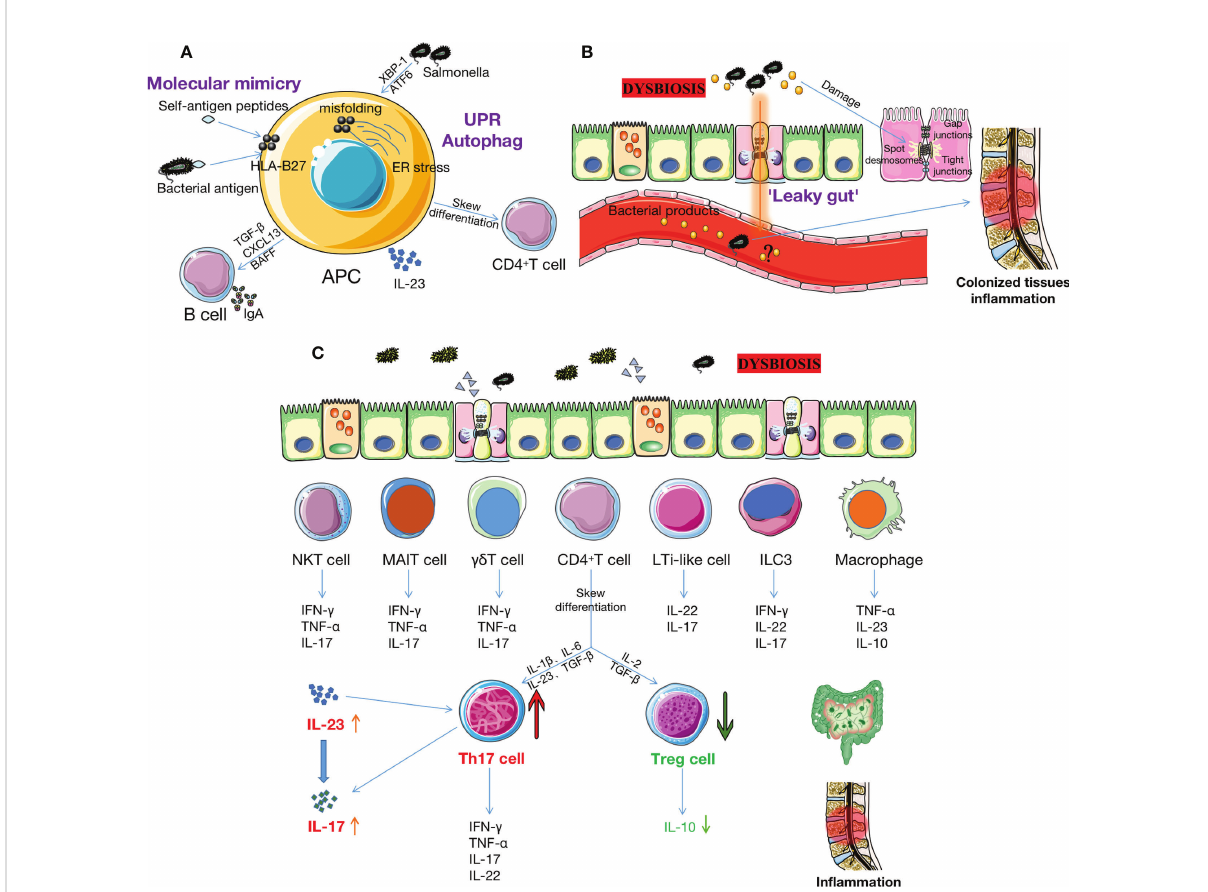
FIGURE 2 The intestinal microbiome and its metabolites may contribute to AS pathogenesis. (A) The interaction of gut microbiota and HLA-B27 may increase the risk of AS through two mechanisms. Firstly, HLA-B27 provides speci fi c peptides, such as certain bacterial antigenic components (e.g.polypeptide structures of Klebsiella and Shigella), to APCs (e.g., CD8+ T or DC cells), resulting in cross-react on molecularly similar self- peptides. Secondly, misfolding of HLA-B27 within ER leads to ER stress, which triggers the UPR or autophagy, activating IL-23/IL-17 axis in the bowel and joints and simultaneously activating B cells to secrete IgA. However, the role of UPR in HLA-B27-driven in fl ammation has not been demonstrated in humans. (B) Dysbiosis leads to increased permeability between IECs, associated with reductions in cathelicidins and mucins, disruption of TJ proteins, impairment of GVBs, etc. Bacteria and bacterial products subsequently enter the bloodstream, inducing in fl ammation of the colonized tissue. However, it is uncertain whether there is bacterial translocation in AS patients. (C) Many immune cells (e.g., Th17, Treg, ILC3, MAIT, gd T, NKT, LTi-like cells, DCs, macrophage et al.) reside in the intestinal mucosa. Dysbiosis triggers these cells to increase pro- in fl ammatory cytokines (such as IL-17, IL-23, TNF- a , IFN- g , IL-7, IL-22, et al.) and decrease anti-in fl ammatory cytokines (such as IL-10). This activates the IL-23/IL-17 pathway and increases the Th17/Treg ratio, ultimately triggering or exacerbating in fl ammation in the gut and joints. AS: ankylosing spondylitis; HLA-B27: human leukocyte antigen B27; APCs: antigen-presenting cells; DC: dendritic cell; ER: endoplasmic reticulum; UPR: unfolded protein response; IECs: intestinal epithelial cells; TJ: tight junction; GVB: gut vascular barrier; Th17: T helper 17 cells; Treg: T regulatory cell; ILC3: innate lymphoid cell 3; MAIT: mucosal-associated invariant T cell; NKT: natural killer T cell; IL-17: interleukin 17; TNF- a : tumor necrosis factor- a ; IFN- g : interferon- g ; SCFAs: short chain fatty acids; Trp: